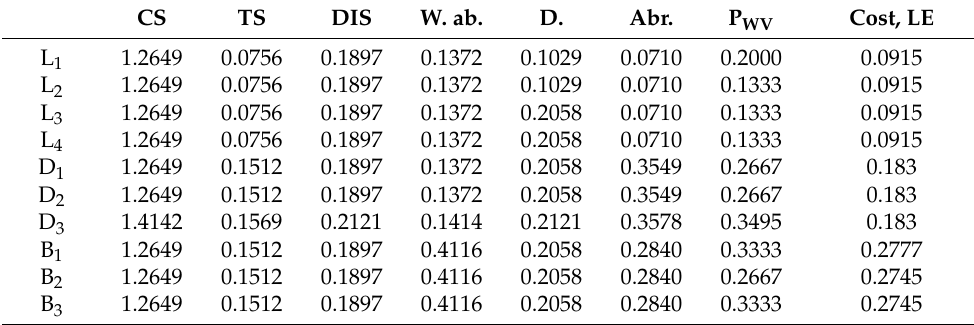
Table 7. Normalized matrix multiplied by rate for every property.